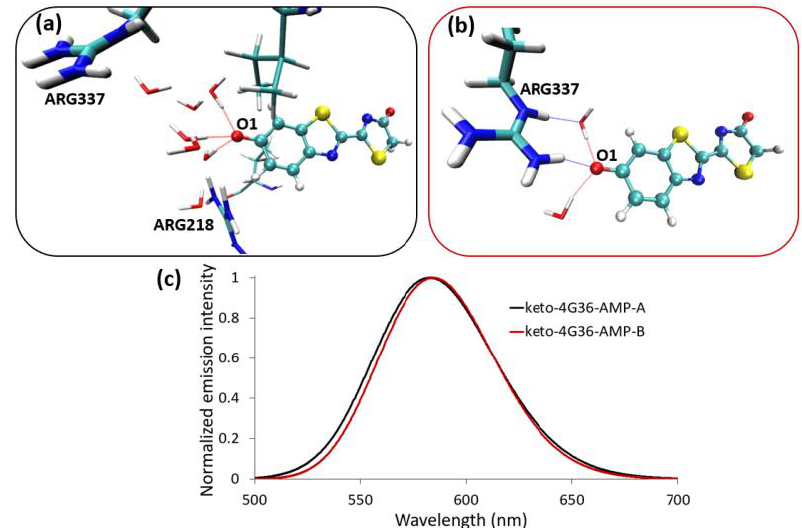
Figure 2. Graphical representation of the two hydrogen-bond patterns found along the simulations (keto-4G36-AMPH as a representative case) between the phenolate moiety (O1) with ( a ) water molecules (pattern 1) or ( b ) ARG377 and water molecules (pattern 2). ( c ) Simulated emission spectra for two MD simulations: MD simulation A of keto-4G36-AMPH (red line) is characterized by hydrogen-bond pattern 1 and MD simulation B of keto-4G36-AMPH (black line) is characterized by hydrogen-bond pattern 2.